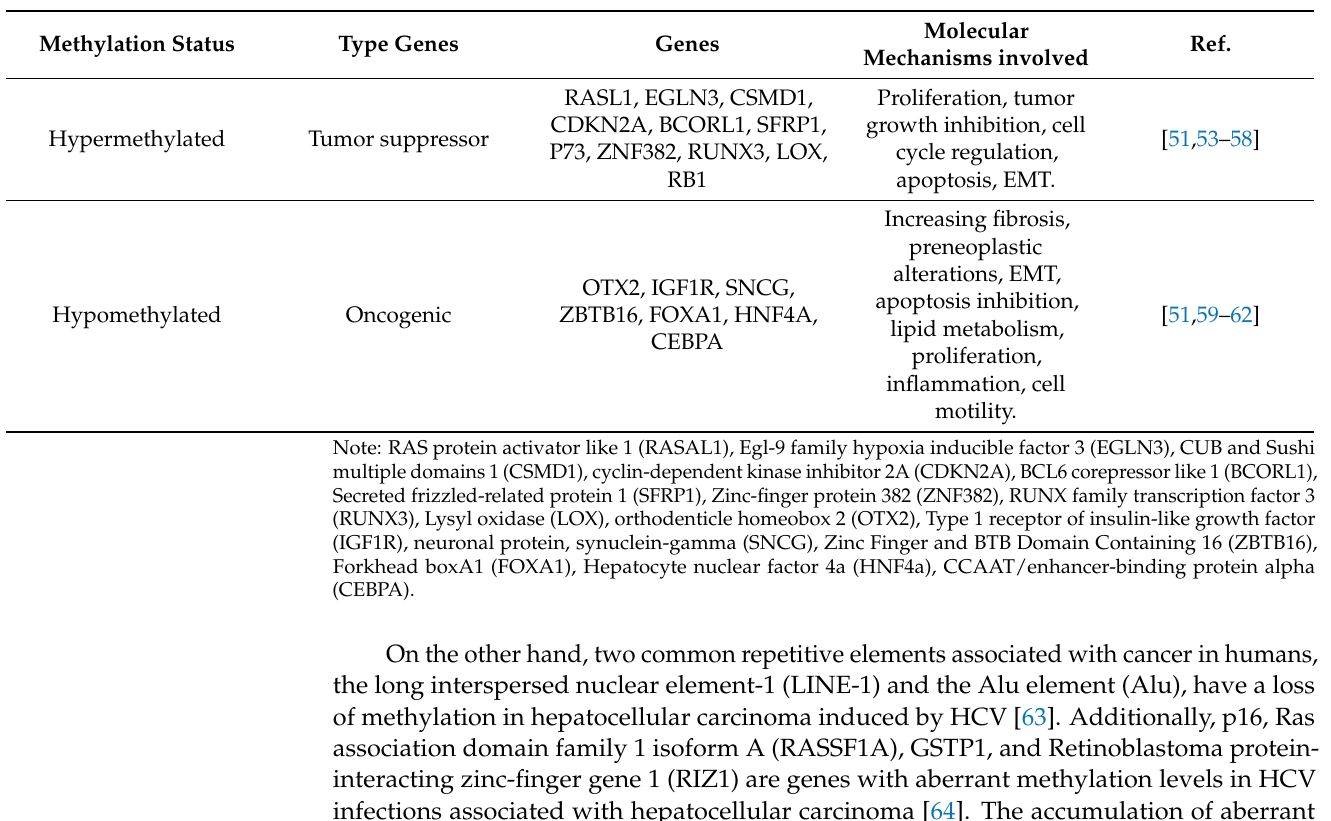
Table 3. Epigenetic modifications associated with hepatocarcinogenesis induced by HCV